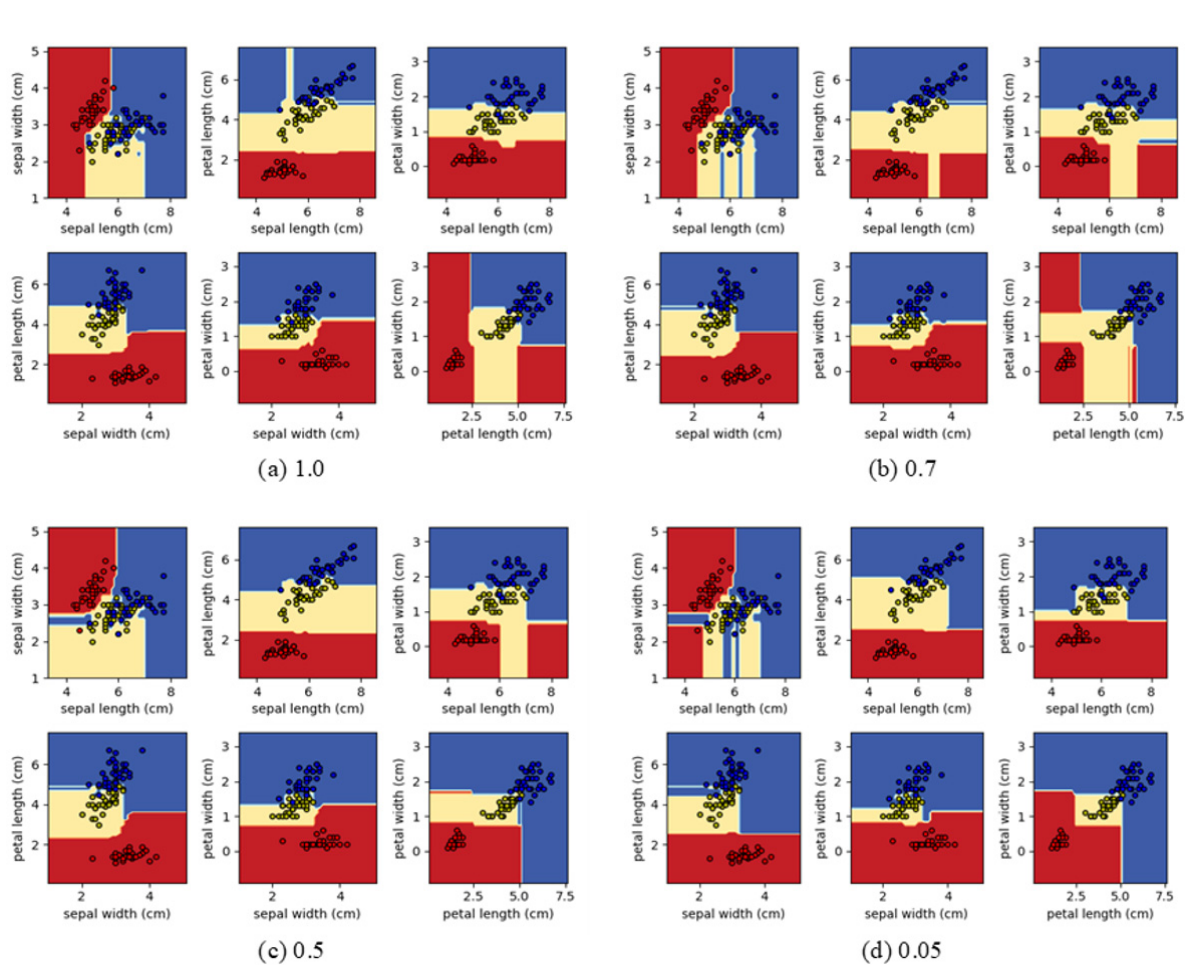
Figure 2. The visualization of decision boundary changes according to the ratio of rule elimination of the fully trained sLMRF using IRIS dataset. The boundary is more obvious in the color image: ( a ) rule ratio 1.0 ( b ) rule ratio 0.7 ( c ) rule ratio 0.5 and ( d ) rule ratio 0.05.